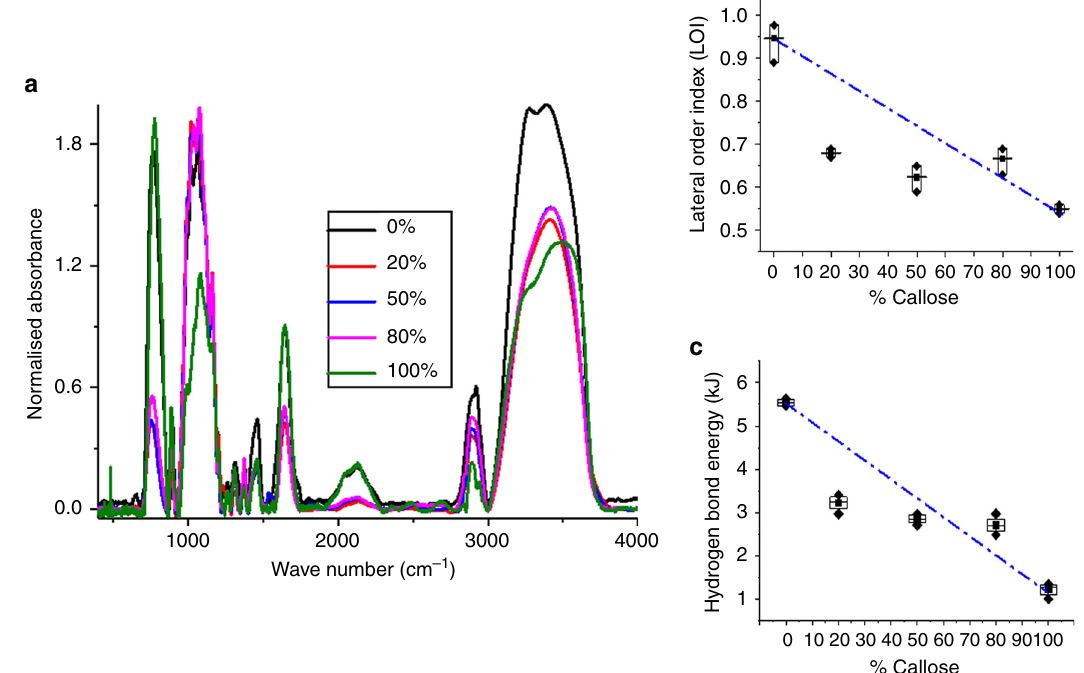
Fig. 7 Fourier-transform infrared spectra show the spectra in hydrogels with increasing callose concentration. a The image shows the superimposed normalised FTIR spectra obtained for hydrogel samples with 0% (black trace), 20% (red), 50% (blue), 80% (magenta) and 100% (green) concentrations of callose. b shows the lateral order index (LOI) and c shows hydrogen bond energy as a function of the different callose concentration. These parameters measure the degree of structural organisation. In both cases, values at 20% callose deviate from ideal mixing (blue dashed line). Boxes represent the fi rst (25%) and third (75%) quartiles, the central line is the mean, and outliers at the 1% and 99% level are indicated by the whiskers. Individual data points correspond to three independent pG1090::icals3m 34,50 . Phenotypic comparison after 24 h treatment of pG1090::icals3m with either the chemical inducer estradiol or with DMSO (control experiment) revealed a substantial increase in callose concentration in different plant tissues (detected using confocal fl uorescent microscopy after aniline blue staining, Fig. 8 and Supplementary Fig. 9). Callose was quanti fi ed in cell walls